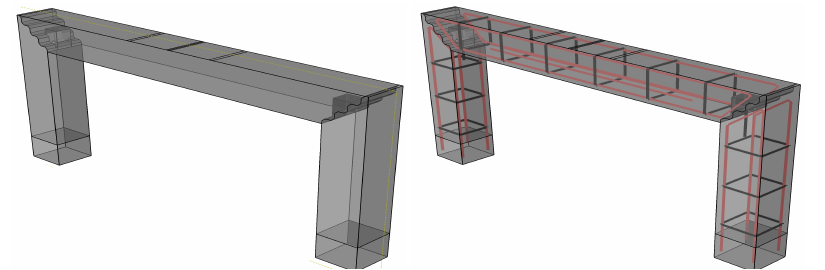
Figure 9. F3, Rebar layout and geometrical dimensions.